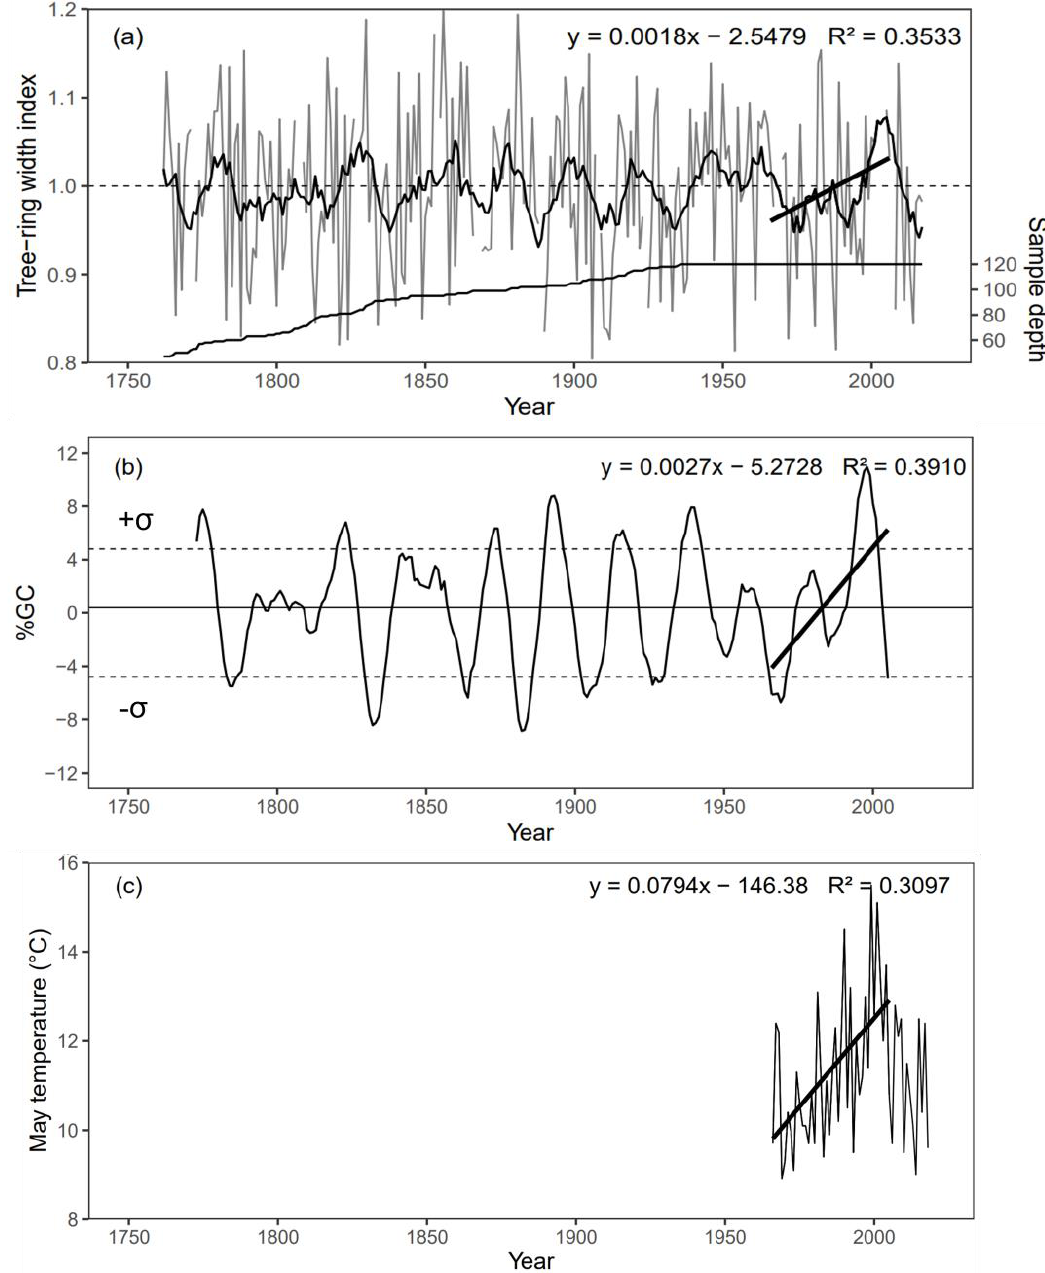
Figure 4. ( a ) Regional chronology (grey line) and its 11-year moving average with a trendline from 1966 to 2006 and sample depth. ( b ) Percentage growth change (%GC) for the regional chronology based on a 5-year moving average with a trendline from 1966 to 2006 (the common period of %GC and climatic data). Dashed lines indicate the thresholds (mean ± 1 standard deviation), and periods above and below these lines are qualified as positive and negative growth rate anomalies, respectively. ( c ) May temperature with a trendline from 1966 to 2006. Table 2. Summary of the positive and negative growth rate anomalies.